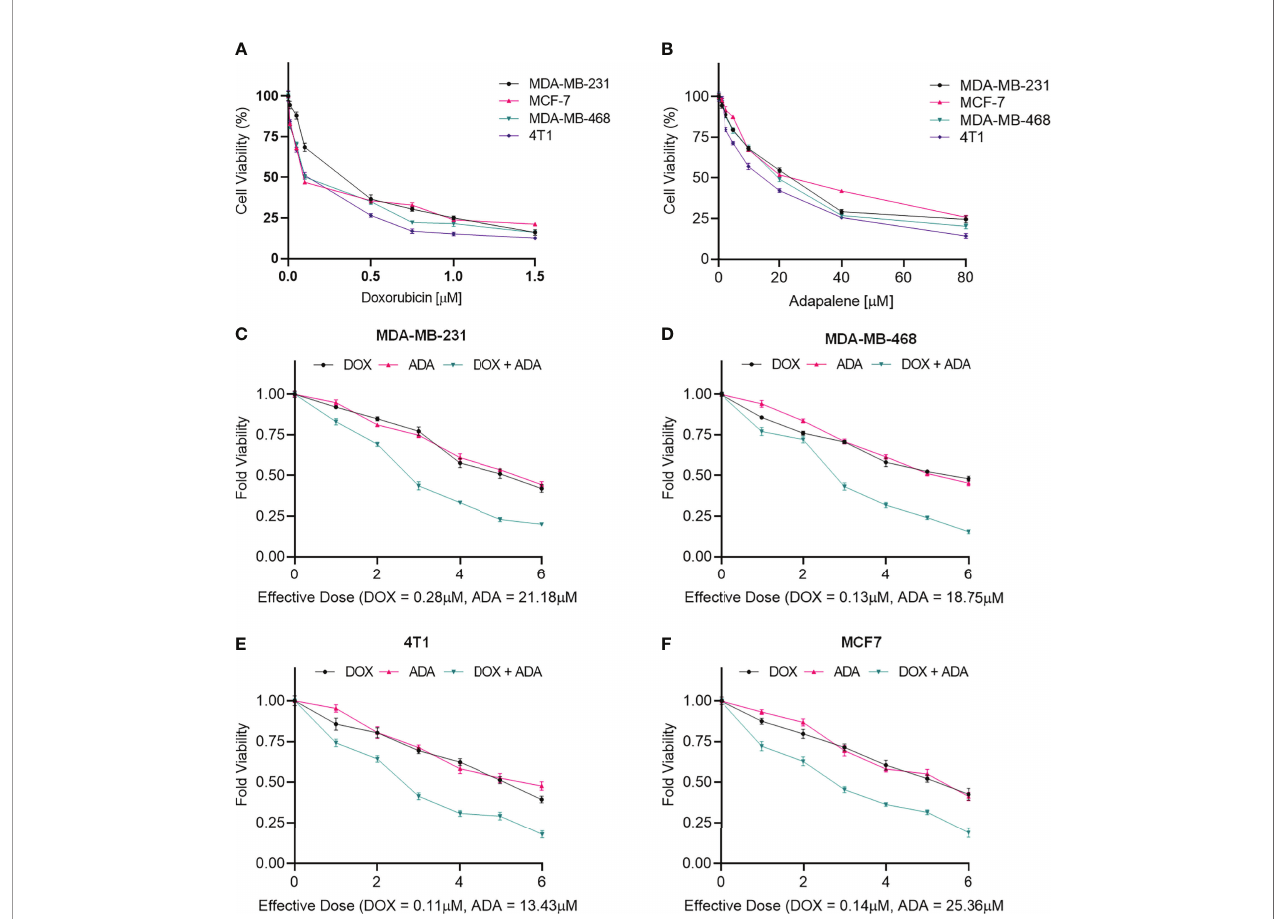
FIGURE 1 | Doxorubicin and adapalene inhibited the growth of BC cells. Cell viability assay of BC cells treated with (A) Doxorubicin and (B) Adapalene. DOX and ADA both inhibited tumor cell growth in a dose-dependent manner. GraphPad prism was used for the calculations of the IC 50 values. Treatment with combination of DOX and ADA showed an enhanced reduction in cell viability of (C) MDA-MB-231, (D) MDA-MB-468, (E) 4T1 and, (F) MCF-7 cells. When ADA and DOX were used together, the cell viability was signi fi cantly reduced, demonstrating that the drugs had advantageous pharmacodynamic interactions with one